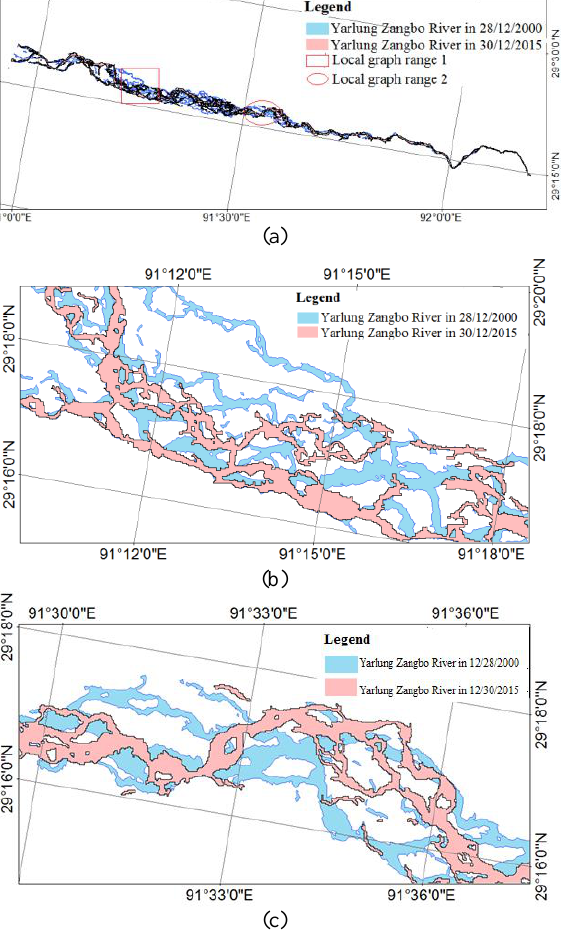
Figure 14. Superimposed river extraction results of midstream of Yarlung Zangbo River in two periods (a) Whole graph (b) Local graph 1 (c) Local graph 2